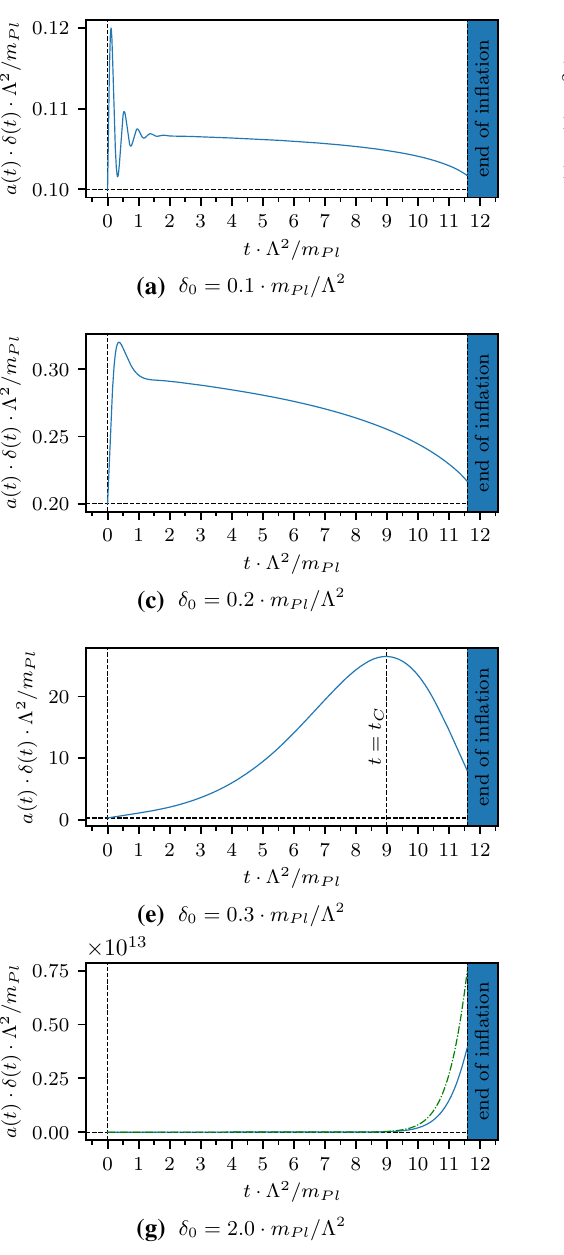
inflation ends is shown by vertical dashed line with the corresponding label. In Fig. 5d–f there is a vertical dashed line which corresponds to t = t C . In Fig. 5g and h there is a green (dash-dotted) line which corresponds to a ( t ) · δ 0 · m